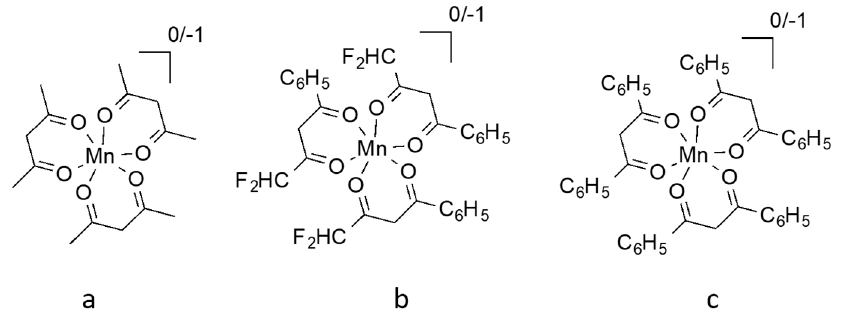
Figure 11. Structures of manganese complexes ( a ) [Mn(acac) 3 ], ( b ) [Mn(CF 2 ) 3 ] and ( c ) [Mn(DBM) 3